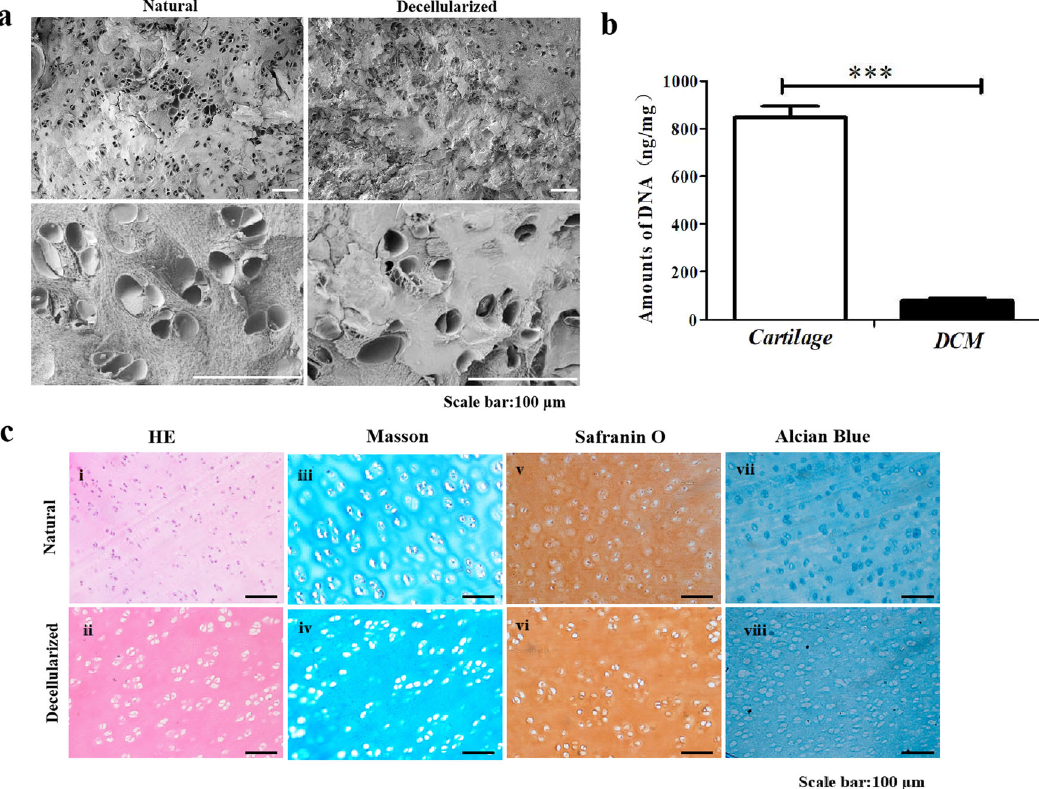
Fig. 1 Characterization of natural and decellularized cartilage tissue. a SEM observation of cartilage. b Data from the DNA content analysis. c Photo micrographs of microtome slices of cartilage pre and post decellularization. Error bars: ± SD, *** p < 0.001. Scale bar = 100 μ